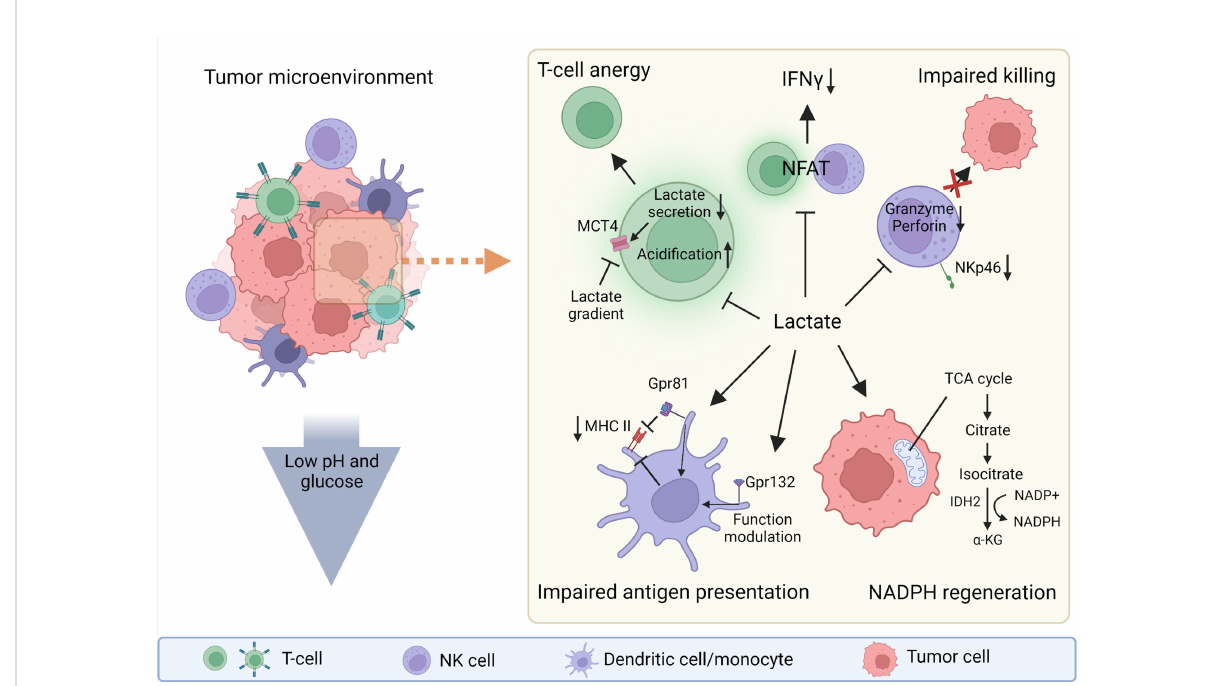
FIGURE 1 The roles of lactate in tumor microenvironment (TME). Lactate can be strongly immunosuppressive in the tumor microenvironment (TME) or can act as a molecule that helps tumor cells to regenerate NADPH and thus maintain redox balance and support their biosynthetic demands. The low pH and low glucose concentration in the TME also support the immunosuppressive function of the TME. Lactate directly or indirectly in fl uences every cell in the TME. Gpr81, lactate receptor; MHC II, major histocompatibility complex class II. Created with